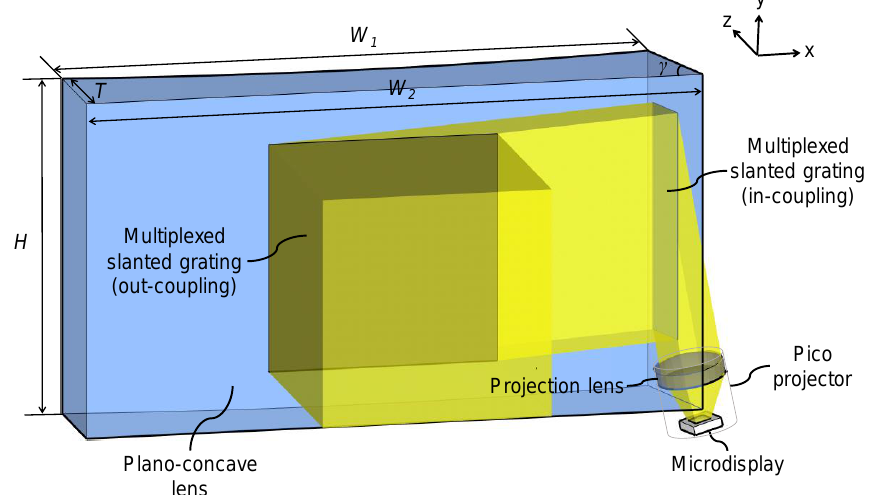
Figure 1. Schematic of the proposed see-through near-eye display (NED). W 1 , W 2 , H , T , and γ are the front width, back width, height, thickness and bevel angle of plano-concave lens,